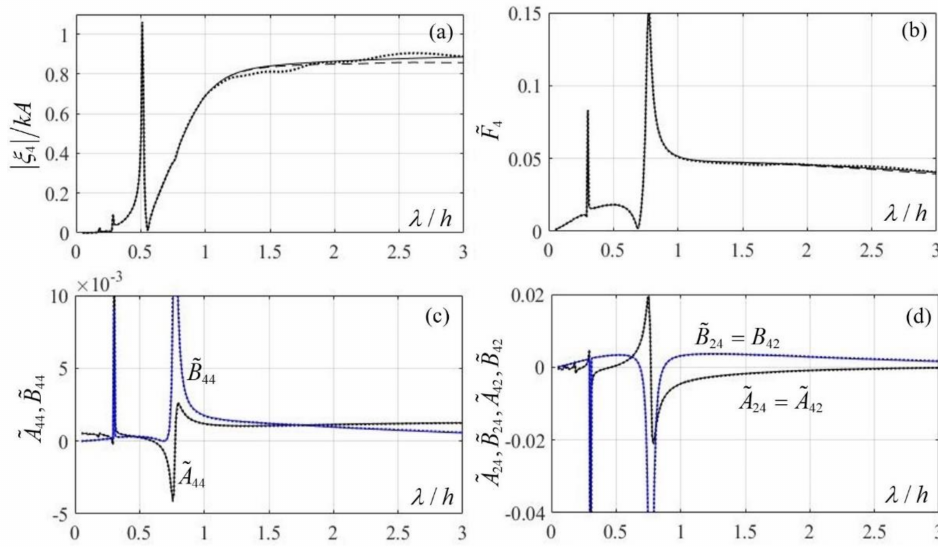
Figure 7. ( a ) RAO in roll motion. ( b ) Hydrodynamic moment (cid:101) F 4 . ( c , d ) Hydrodynamic coefficients A 44 , B 44 and A 24 , B 24 , respectively. All quantities are plotted vs. the non-dimensional wavelength λ / h , where h denotes the average water